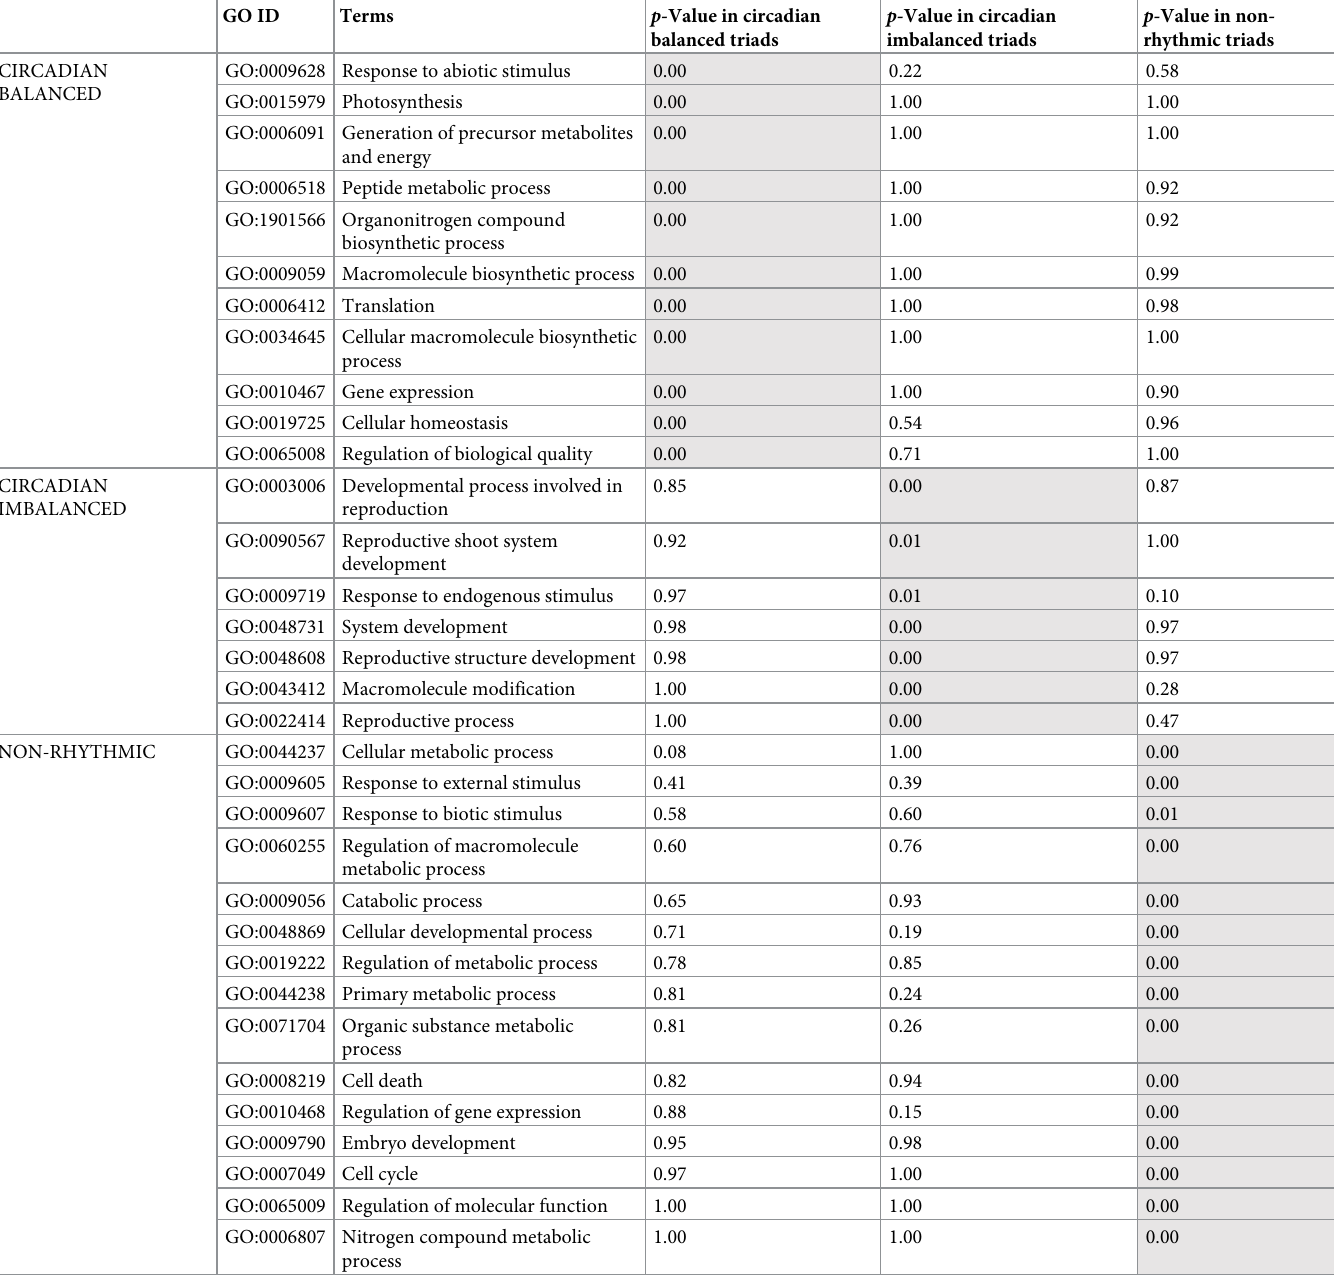
Table 2. GO-slim terms for biological processes associated with circadian balanced, circadian imbalanced, and arrhythmic wheat triads. GO ID CIRCADIAN